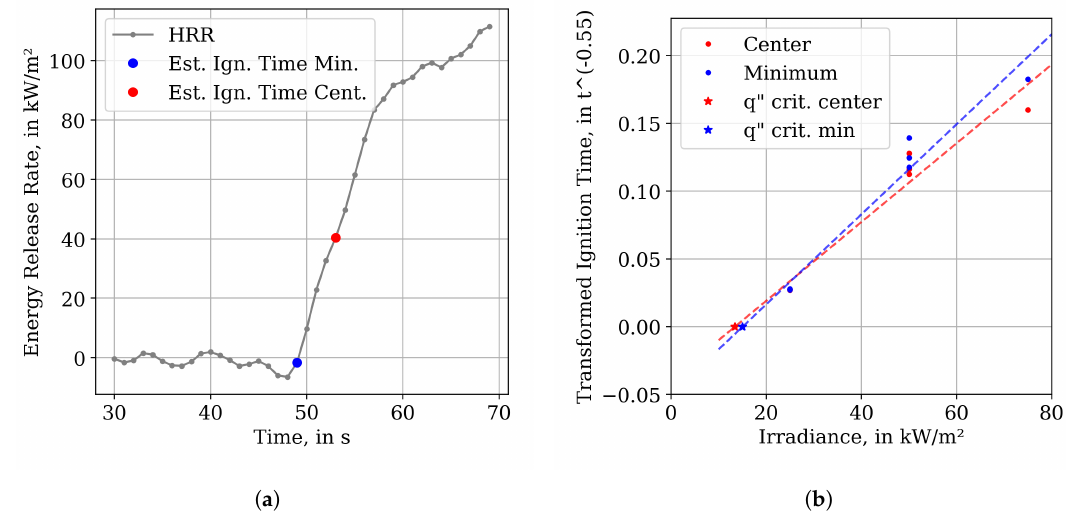
Figure A8. Illustration of the procedure to estimate ignition times in the Cone Calorimeter experiments. ( a ) Illustration of how the ignition times were estimated, based on a repetition of 50 kW / m 2 Cone Calorimeter test. The blue dot indicates the minimum ignition time, while the centre is marked in red. ( b ) Estimation of the critical heat fluxes, based on the “minimum” and “centre ignition times”. Note: At 25 kW / m 2 six data points are overlapping, three red, three blue.